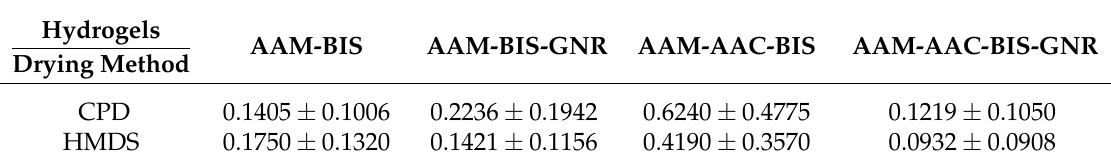
Table 1. Mean and standard deviation of Feret diameters of hydrogel pore structures in µ m. CPD: Critical Point Drying. HMDS: